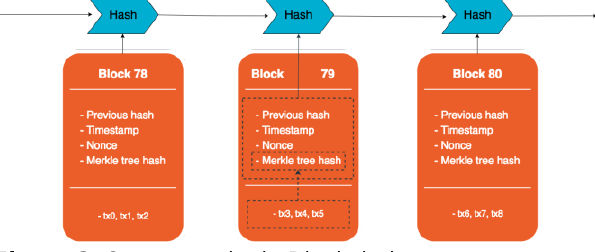
Figure 3. Cryptography in